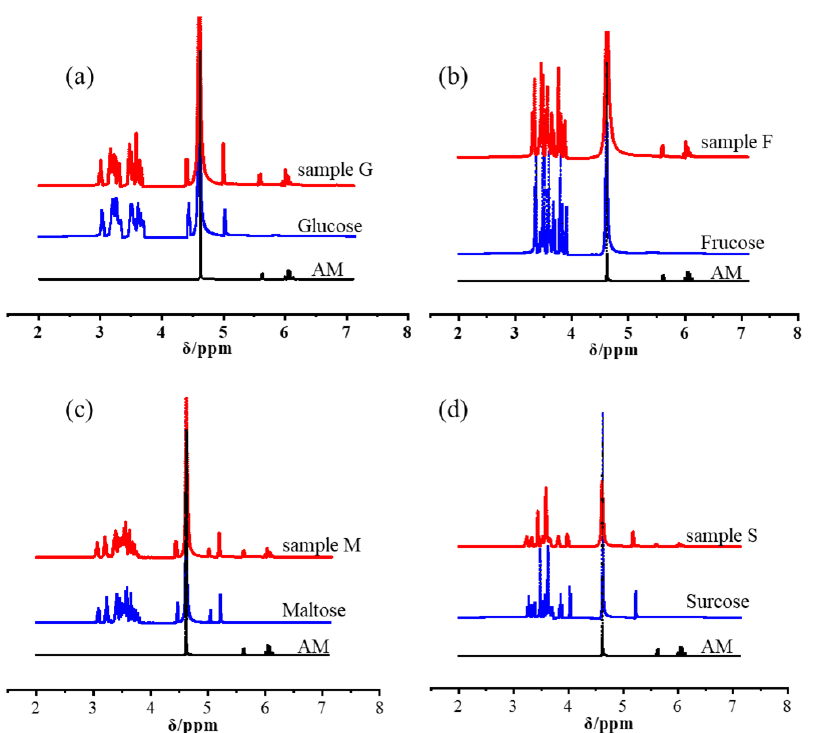
Figure 2. The 1 H NMR spectra of ( a ) glucose, AM and sample G, ( b ) fructose, AM and sample F, ( c ) maltose, AM and sample M, ( d ) sucrose, AM and sample S.